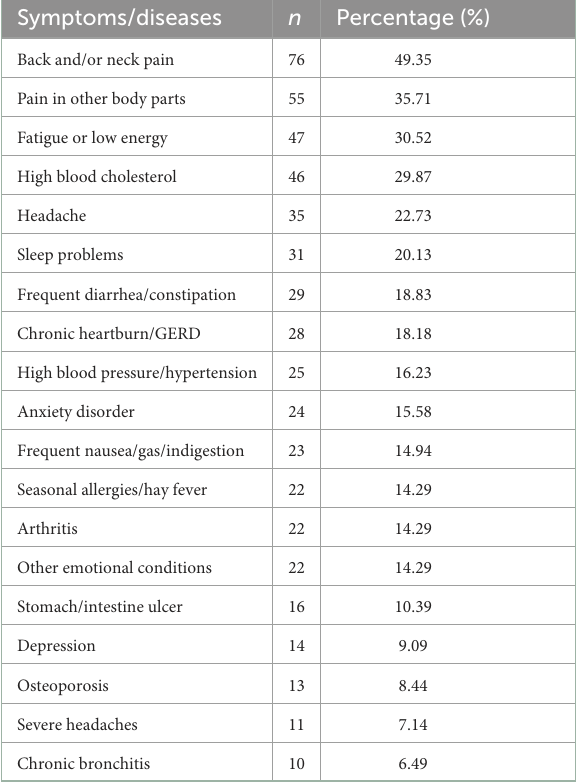
TABLE 2 The health conditions affecting 5% or more of the